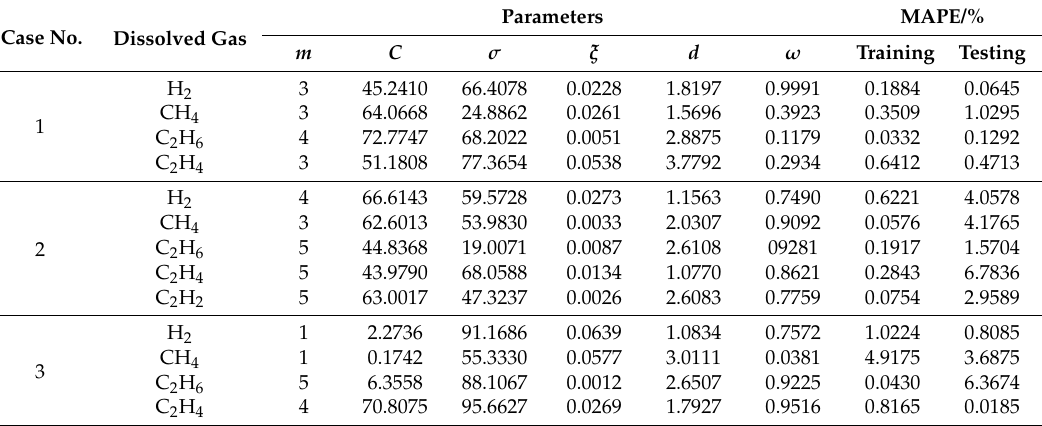
Table 5. The optimal parameters of each dissolved gas sequence.